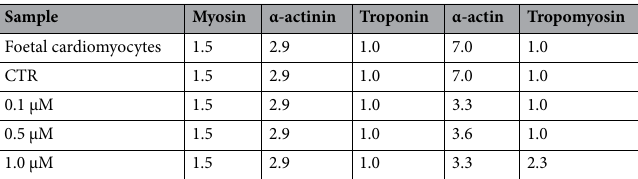
Sample Myosin α-actinin Troponin α-actin Tropomyosin